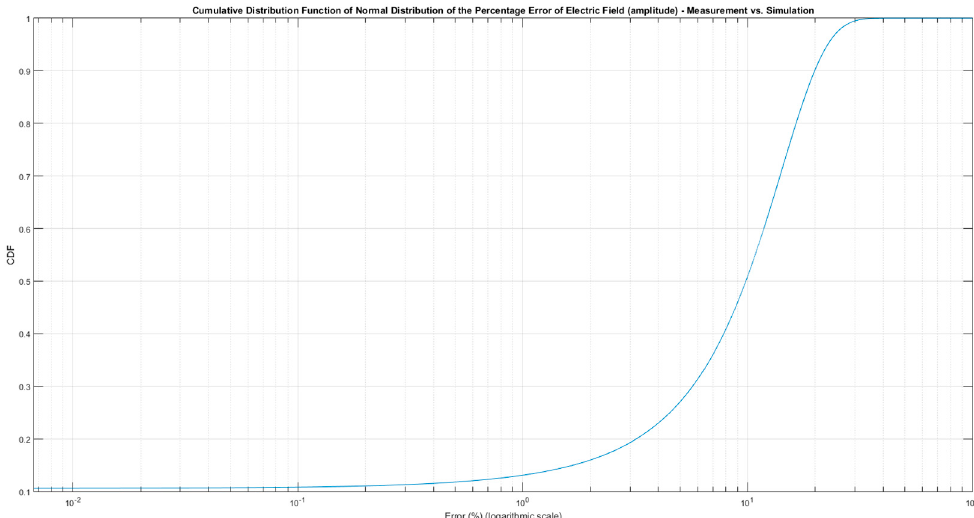
Figure 13. Cumulative Distribution Function (CDF) of Normal Distribution of the Percentage Error of Electric Field (amplitude) in logarithmic scale in X axis.